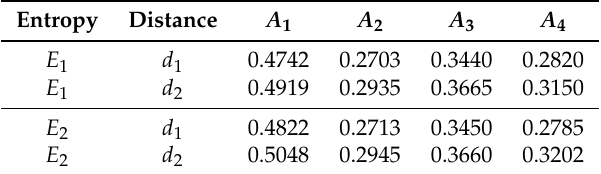
Table 2. Dual hesitant weighted distances of alternatives to PIS.